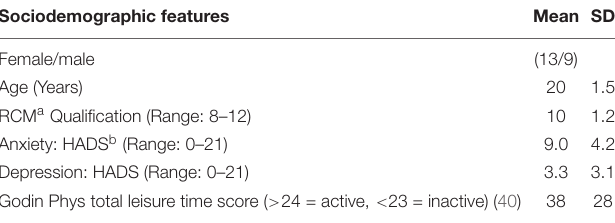
TABLE 1 | Background characteristics of